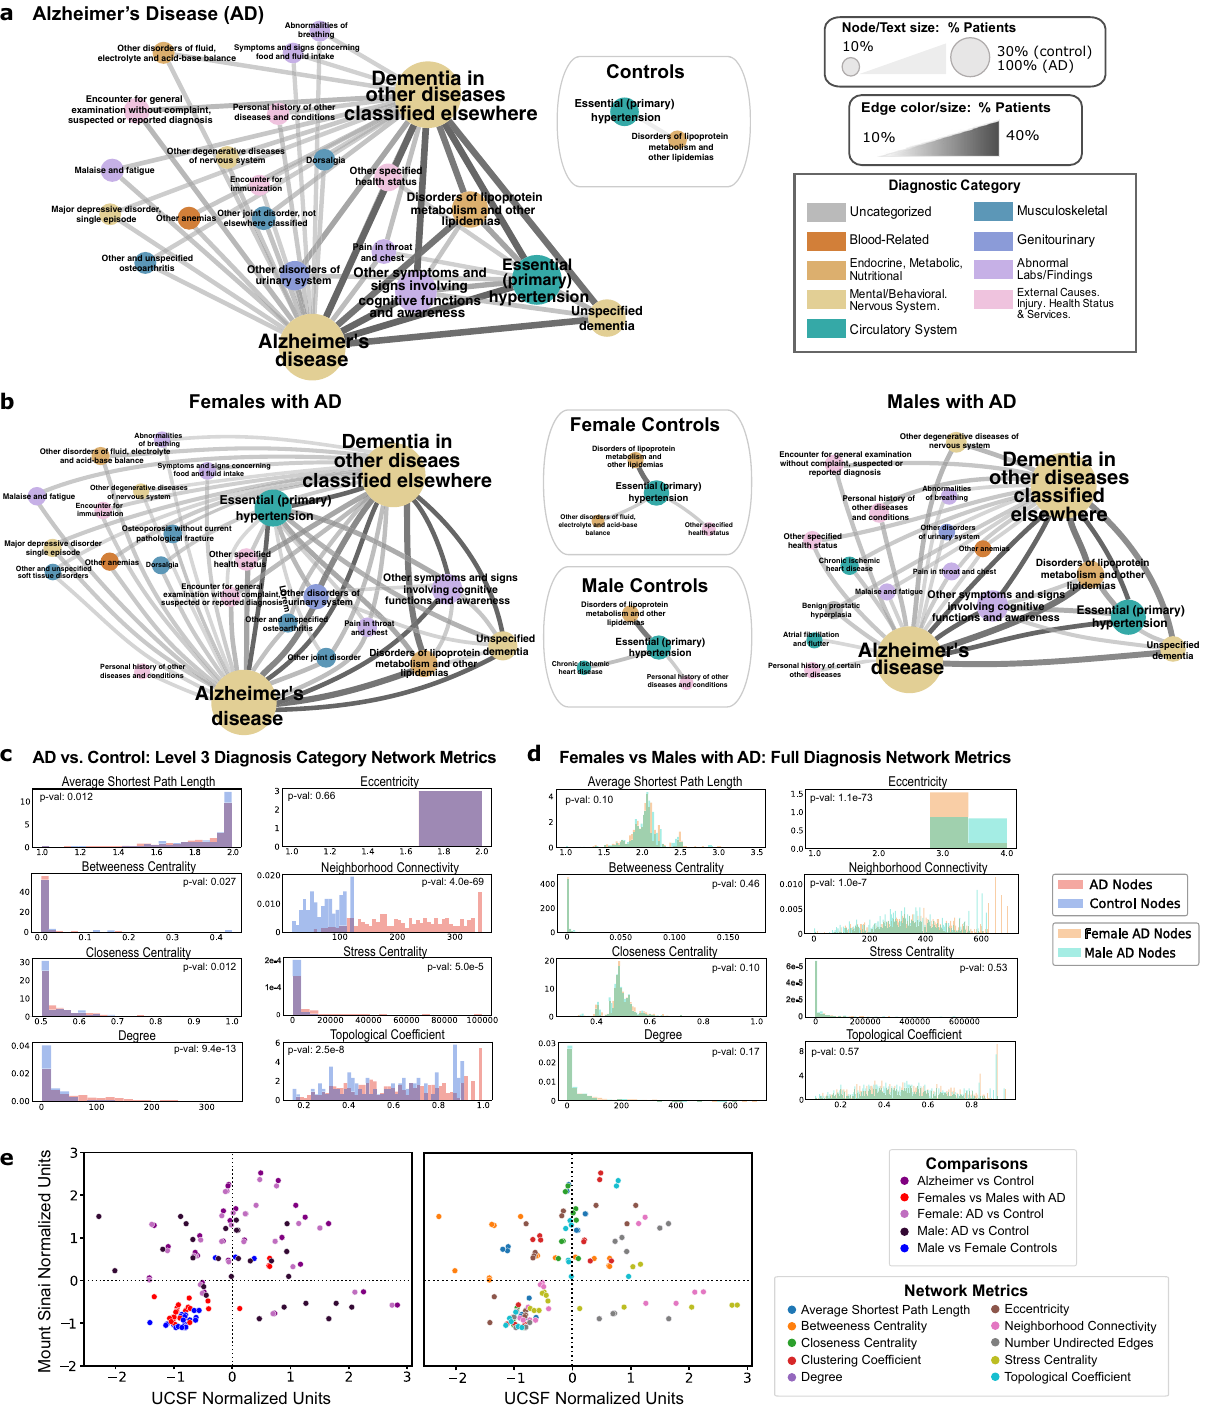
Fig. 3 Comorbidity networks show greater co-diagnosis in patients with AD vs. controls, and in females with AD vs males with AD. a , b Network diagrams: For each network, the node size, text size, edge size, and edge color represent the number of patients sharing a diagnosis or diagnosis pair. Node colors are based on ICD-10-CM category. A threshold of 10% sharing was applied. a Network for Level 3 diagnosis categories in patients with AD vs. controls. Nodes and edges represent >10% of diagnosis or diagnosis pairs shared in each cohort, respectively. b Female and male network of Level 3 diagnosis categories for patients with AD and controls. Each node and edge represent a diagnosis or diagnosis pairs shared by >10% of males or females in the AD or control group. c Comparison of Level 3 diagnosis category network metrics between patients with AD and controls. Statistical tests are performed with a two-sided Mann – Whitney U -test. Signi fi cant metrics with p -value < 0.01: degree (9.4e − 13), neighborhood connectivity (4.0e − 69), stress centrality (5.0e − 5), and topological coef fi cient (2.5e − 8). d Comparison of network metrics between male and female Alzheimer ’ s disease full diagnostic name networks. Statistical tests are performed with a two-sided Mann – Whitney U -test. Signi fi cant metrics with p -value < 0.01: eccentricity (1.1e − 73) and neighborhood connectivity (1.0e − 7). e Correlation of network metrics compared with validation EMR network metrics, normalized by the metric. Colors represent comparison type (left) or the speci fi c network metric (right), Spearman ’ s ρ = 0.55, p -value < 1e − 4.